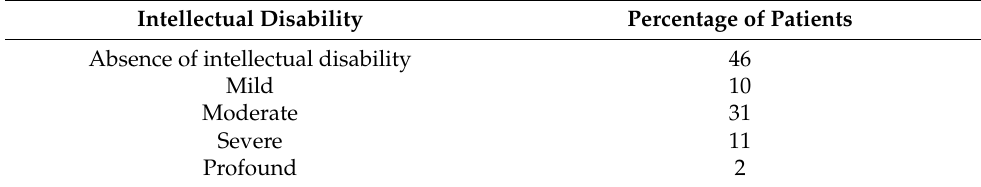
Table 4. Intellectual functioning of patients with Dravet syndrome.